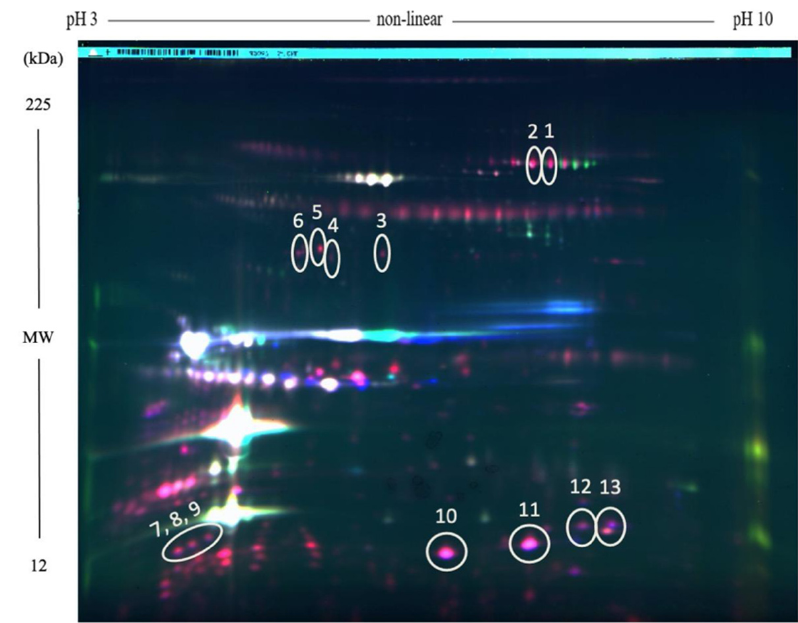
Figure 2. Proteins in mastitic milk (red spots) vs proteins from healthy milk (green spots) in two- dimensional differential gel electrophoresis (2D-DIGE) image. Proteins with similar levels in both groups are indicated by white spots [80.]